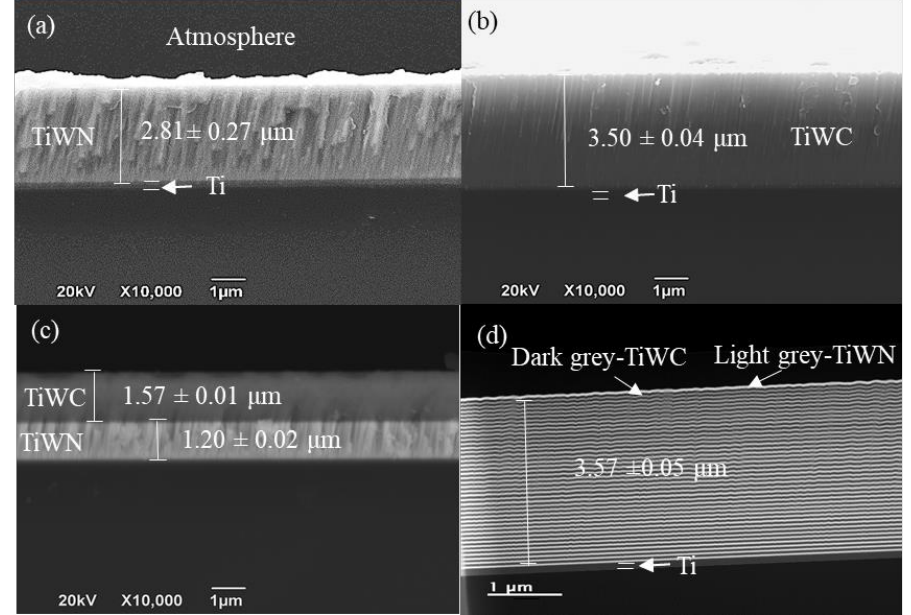
Figure 2. Cross-section SEM images of the coatings, ( a ) Ti-W-N monolayer, ( b ) Ti-W-C monolayer, and ( c ) n = 1. HR-TEM micrographs ( d ) n = 40 deposited on Si (001)/Ti by RF magnetron